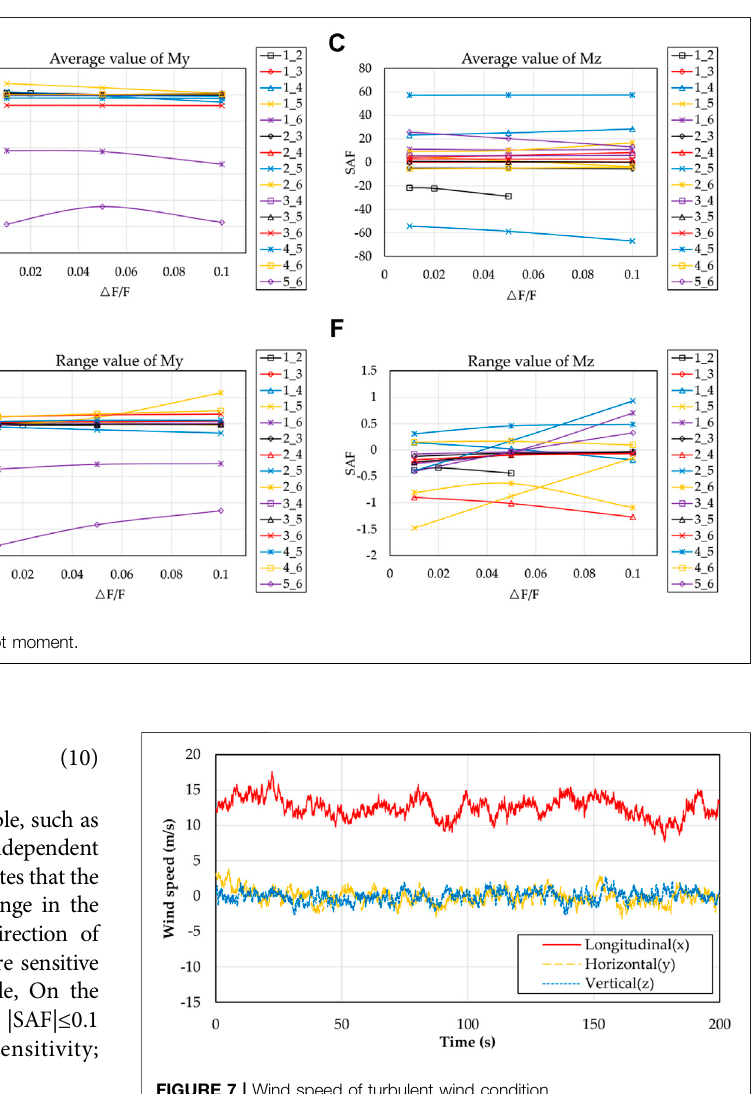
FIGURE 7 | Wind speed of turbulent wind